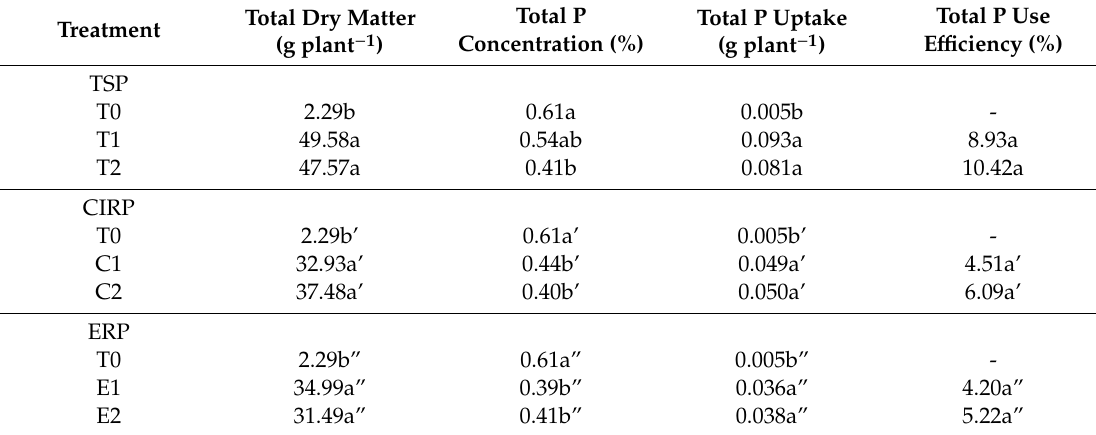
Table 8. Total dry matter production, total phosphorus concentrations, total phosphorus uptake, and phosphorus use e ffi ciency in maize at fifty days after